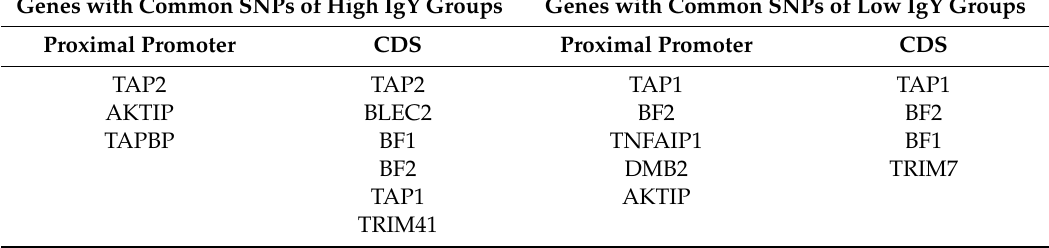
Table 8. Genes with common SNPs to the high IgY groups or low IgY groups in proximal promoter or CDS.